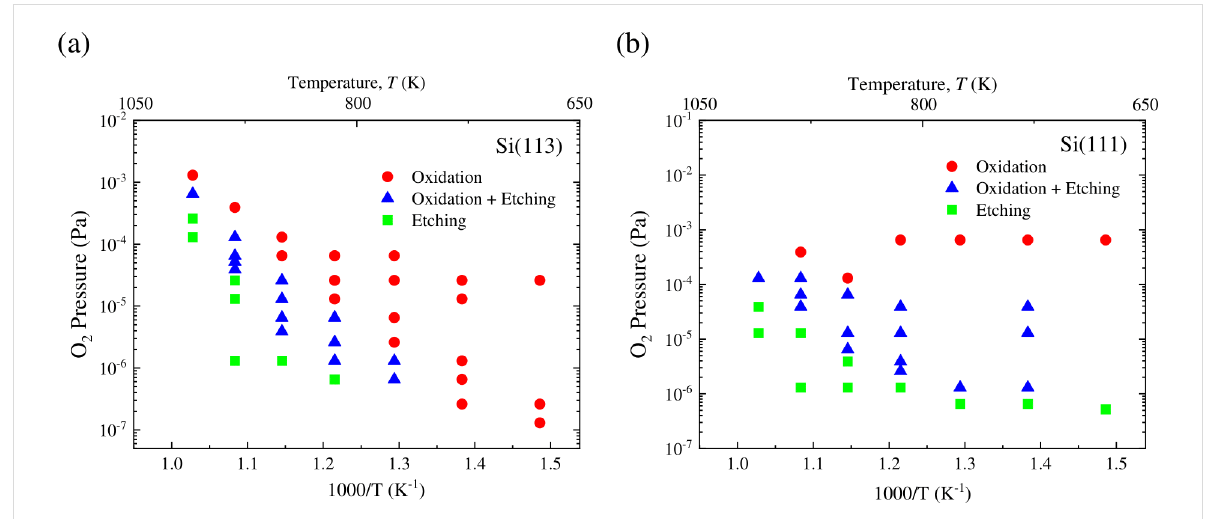
Figure 6: Temperature–pressure growth mode diagram for thermal oxidation on (a) Si(113) and (b) Si(111).